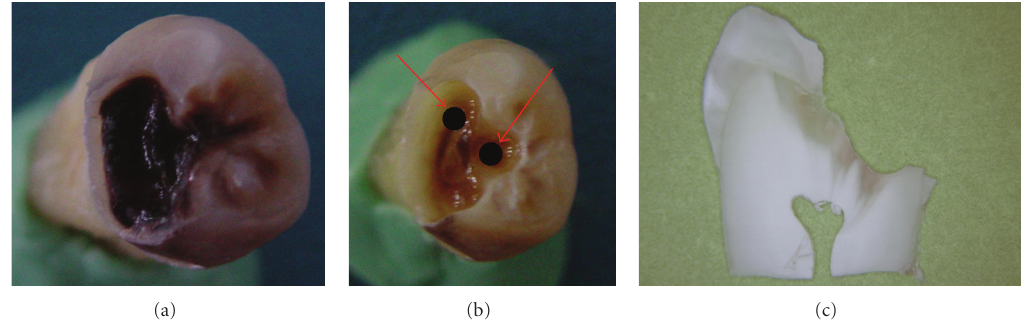
Figure 1: (a) D3 caries: (b) After caries dentin was mechanically removed, to ensure that the same spots were analyzed each time, two signs were done on photographs with a black pen (c) histological section.